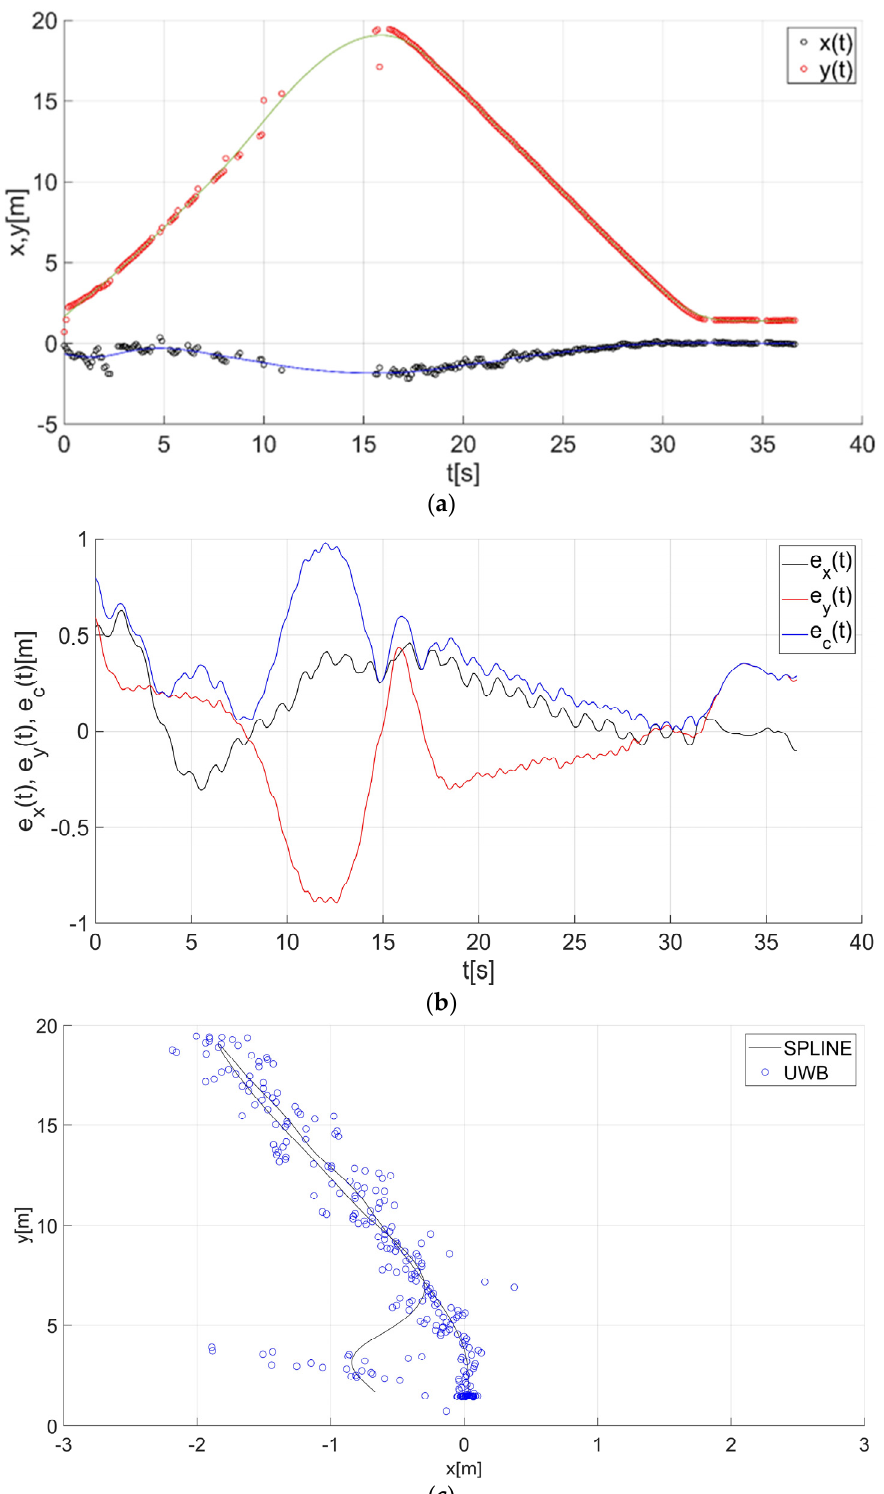
Figure 16. Results for the estimation of guide path no. 4 with the use of the smoothing spline: ( a ) the course of the guide’s location coordinates x(t), y(t) with their continuous estimates, ( b ) the course of the estimated location errors e x (t), e y (t), e c (t), ( c ) guide’s location along with the path estimation [6].